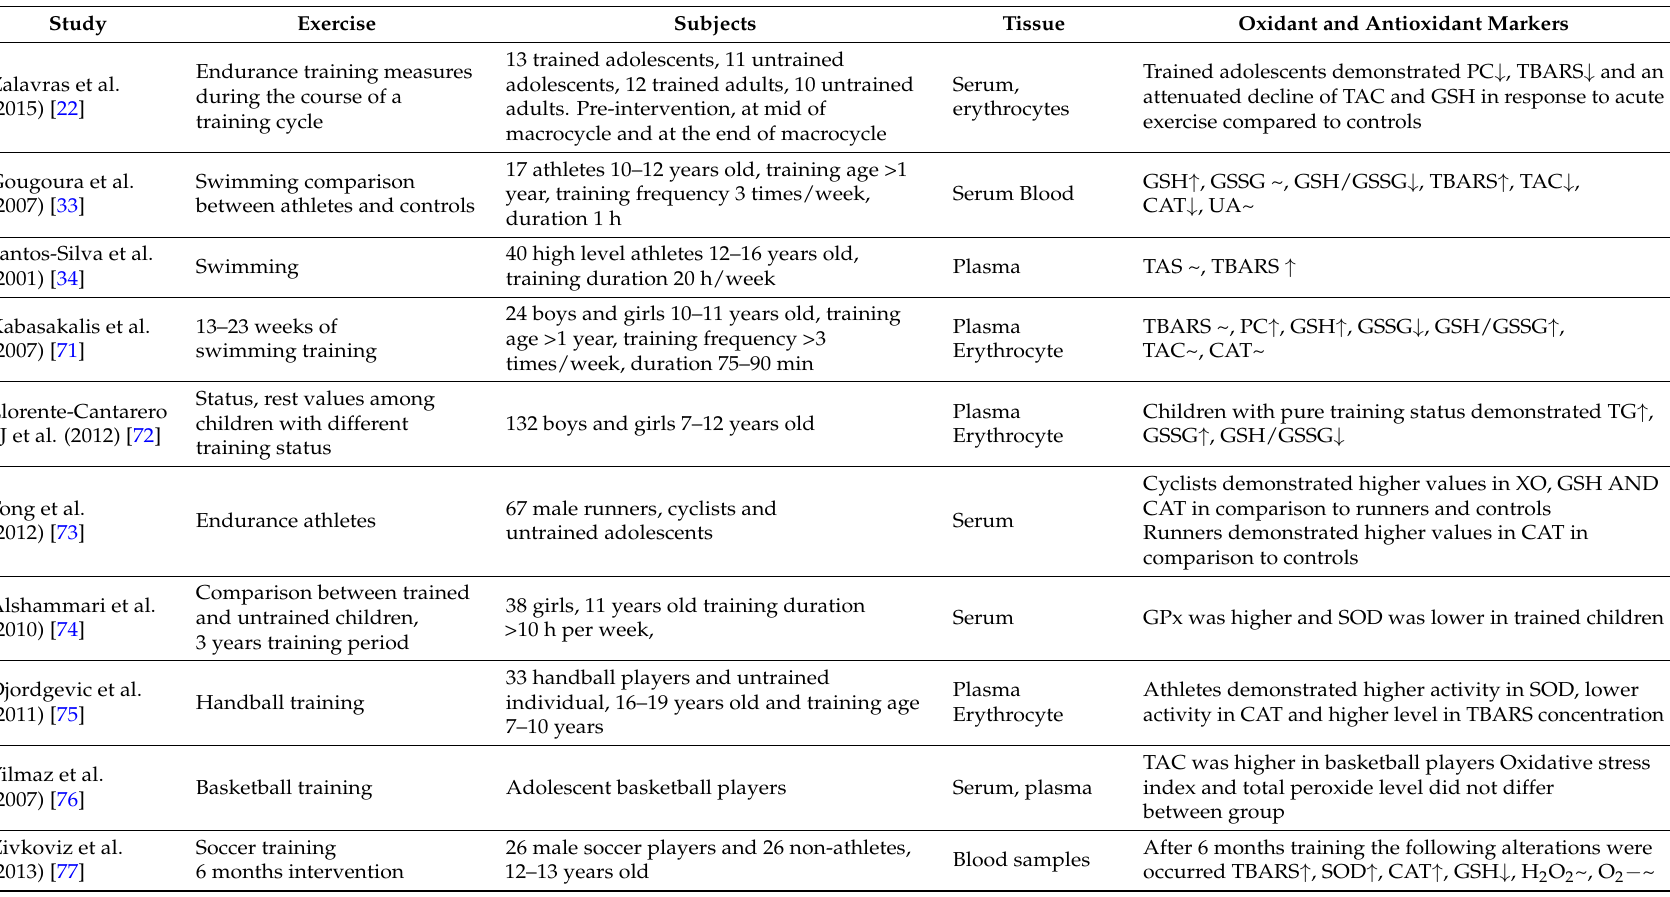
Table 2. Chronic adaptations of exercise on oxidant and antioxidant